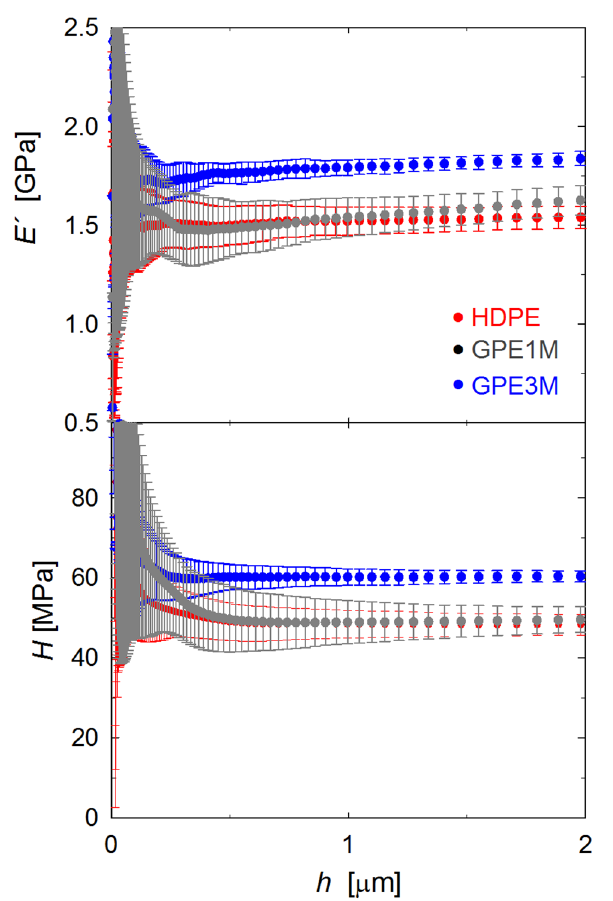
Figure 4. Storage modulus, E´ , and hardness, H , as a function of indenter displacement for HDPE and the two nanocomposites with modified graphene prepared using melt extrusion.